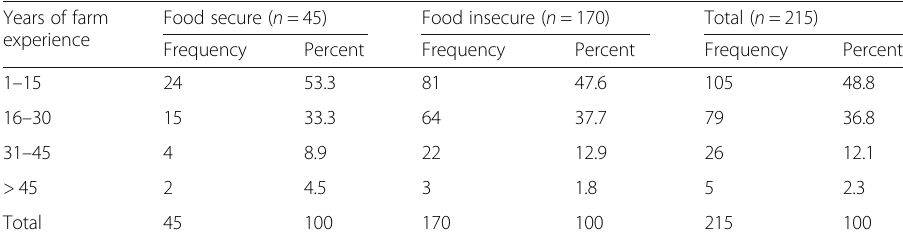
Table 3 Sample household head ’ s farming experience and their food security status